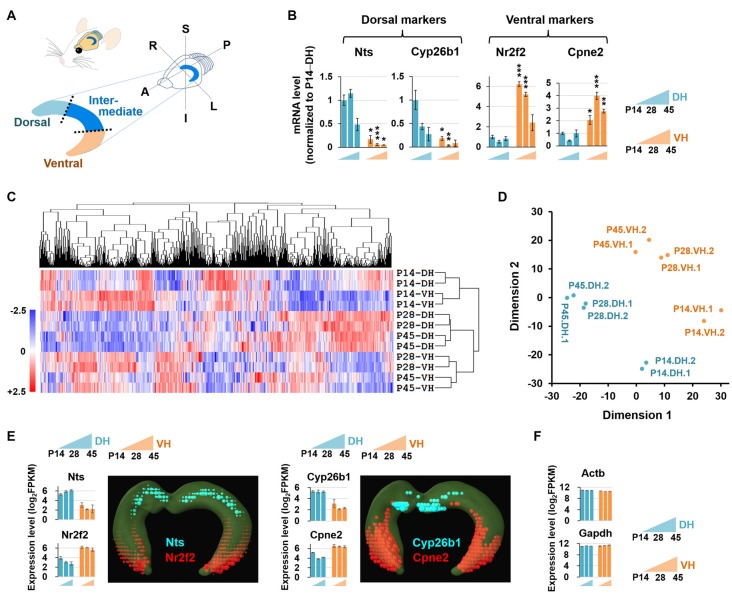
Experimental setup for RNA sequencing (RNA-seq)-based transcriptome analysis. (A) Diagram illustrating the dissection strategy of the dorsal and ventral hippocampus used in this study. A, anterior; P, posterior; S, superior; I, inferior; R, right; L, left. (B) Relative mRNA levels based on qRT-PCR results of the dorsal (Nts, Cyp26b1) and ventral (Nr2f2, Cpne2) markers in the developing hippocampus. n = 3–5 independent samples. Data represent mean ± SEM. *p < 0.05, **p < 0.005, ***p < 0.0005 compared with the corresponding DH at the same age, Student’s t test. Refer to Supplementary Table S5 for detailed statistics, including n number, t-value, degree of freedom and p-value for individual genes. (C) Hierarchical clustering analysis of RNA-seq data. Genes in duplicates are well clustered with one another. The values of log2FPKM were normalized to the value ranges from a minimum of −2.5 to a maximum of +2.5. (D) Multidimensional scaling plot for RNA-seq data. Dimension 1 and dimension 2 separate all 12 RNA-seq libraries based on the gene expression value. Euclidean distances were used to generate the plot. (E,F) Expression levels of the genes previously reported to be enriched in the dorsal (Nts, Cyp26b1) or ventral (Nr2f2, Cpne2) hippocampus (E) and evenly distributed throughout the hippocampus (Actb, Gapdh) (F). Graphs indicate RNA-seq–based gene expression (rat brain). Data represent mean ± SEM. Images denote in situ hybridization–based gene expression (mouse brain) using ABA Brain Explorer 2. DH, dorsal hippocampus; VH, ventral hippocampus; P, postnatal day.